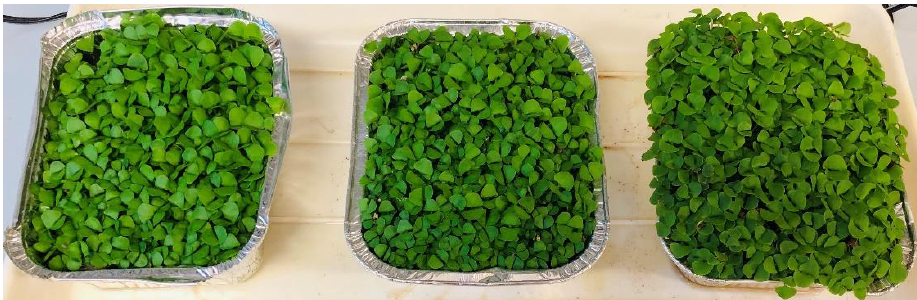
Figure 8. From left to right: green basil microgreens grown on jute, vermiculite and coconut fiber. This species showed high concentrations of chlorophyll a + b .